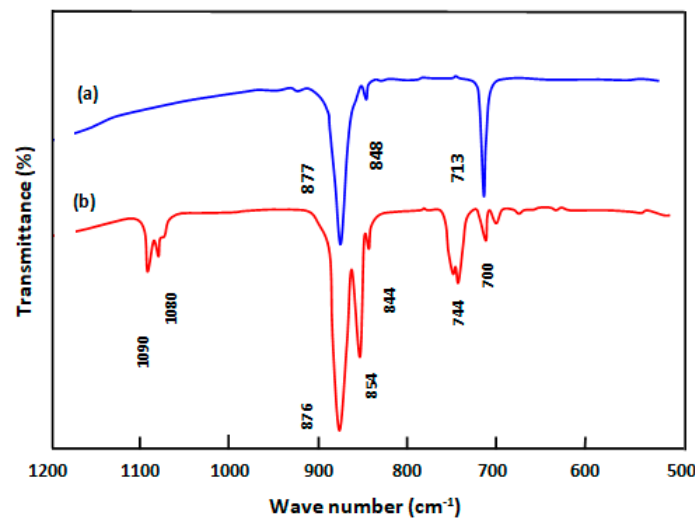
Figure 12. FT-IR spectra of the calcium carbonate crystals formed in the blank ( a ) and in 10 mg · L − 1 CA-co-GLC ( b ).